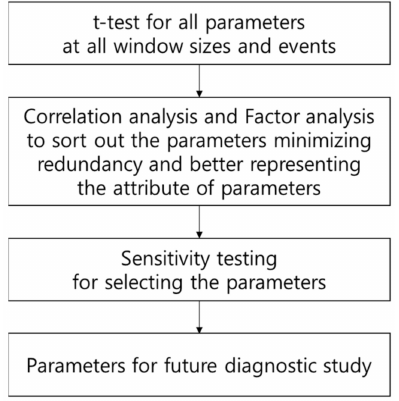
Figure 3. Data analysis